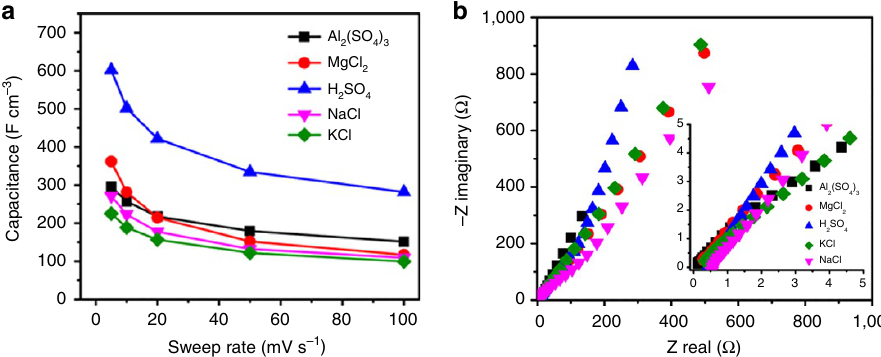
Figure 4 | Electrochemical performance of 2D h -MoO 3 in aqueous electrolytes. ( a ) Volumetric capacitance as a function of the sweep rate in different aqueous electrolytes. ( b ) Nyquist plots obtained in H 2 SO 4 , MgCl 2 , NaCl, KCl and Al 2 (SO 4 ) 3 electrolytes. NATURE COMMUNICATIONS|7:11296|DOI: